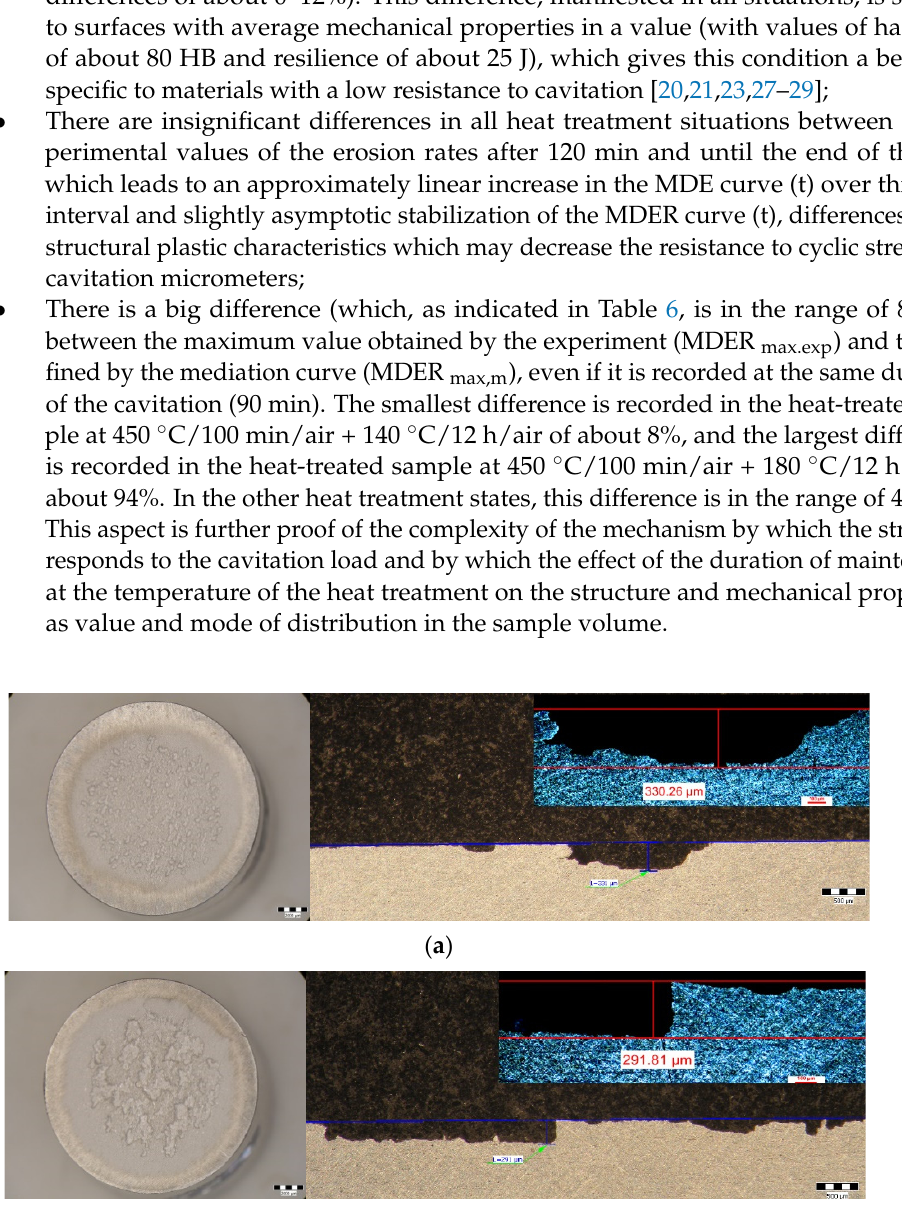
Figure 12. Appearance of macrostructural surfaces (left front section, parallel to the eroded surface, right in cross section, background image under an optical microscope, detail image under a stereomicroscope) subjected to cavitation erosion from alloy 5083, poured followed by hardening solution 450 ℃ /maintenance 100 min/cooling air quietly and subjected to artificial aging at 180 ℃ and different maintenance times: ( a ) 1 h; ( b ) 12 h; ( c ) 24 h .